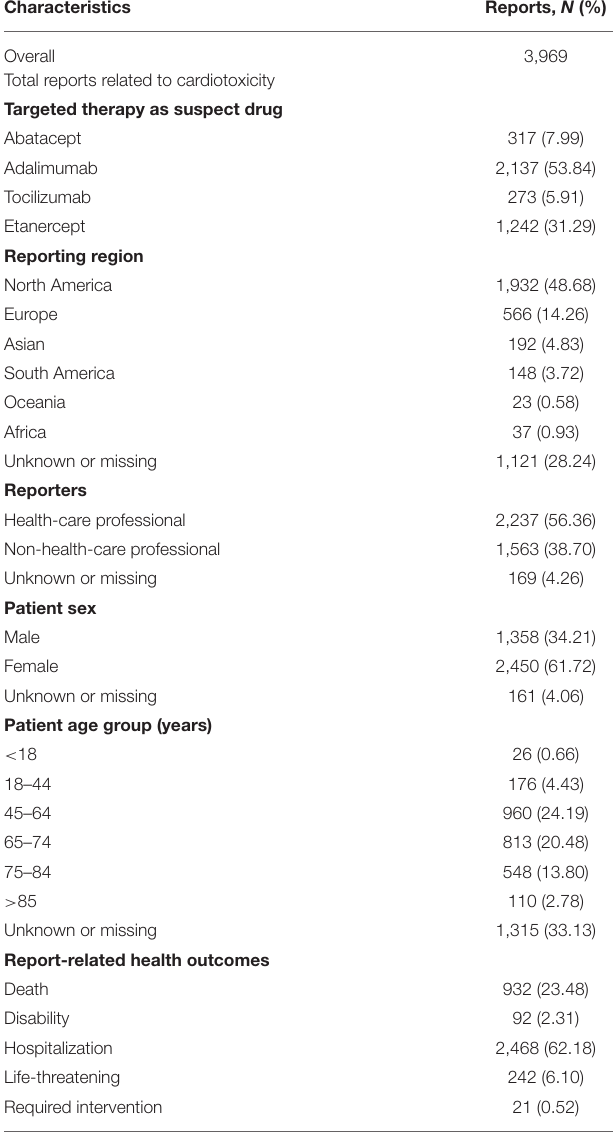
TABLE 3 | Clinical characteristics of patients with four agents associated with cardiotoxic events collected from the Food and Drug Administration’s Adverse Event Reporting System (FAERS)